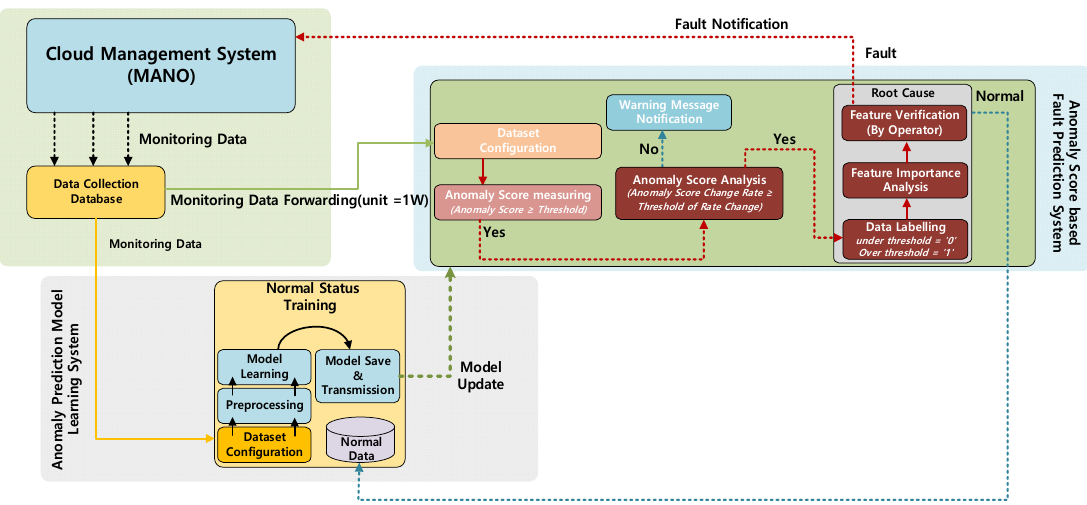
Figure 13. ML based Cloud management System.